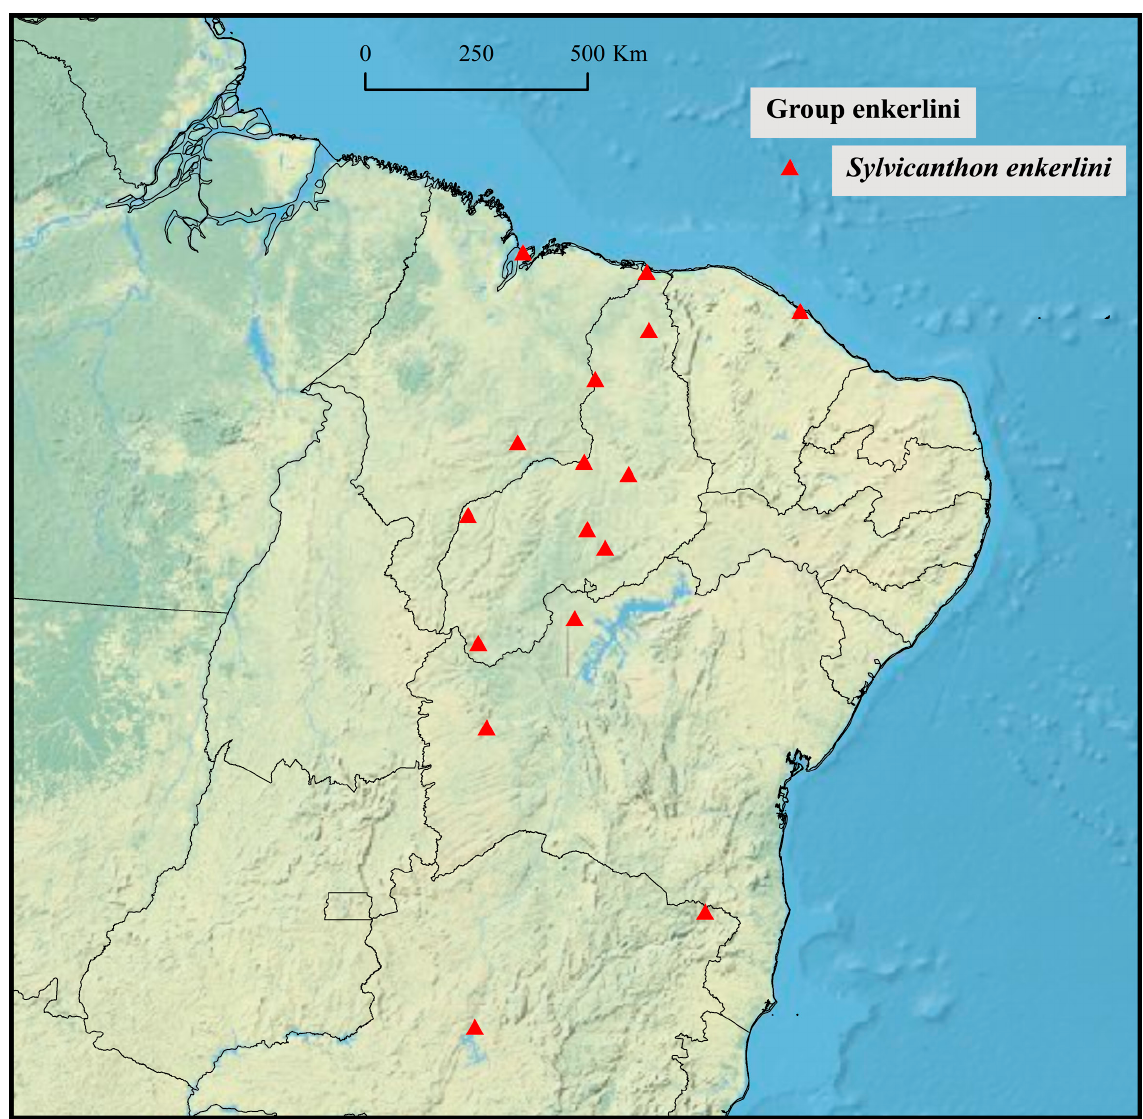
Fig. 22. Distribution of Sylvicanthon enkerlini (Martínez et al. , 1964) comb. nov. Note that the species occupies transition zones between the Amazonia, Cerrado, Caatinga and Atlantic Forest biomes, regions much dryer and more open than the humid forests occupied by the species of the candezei